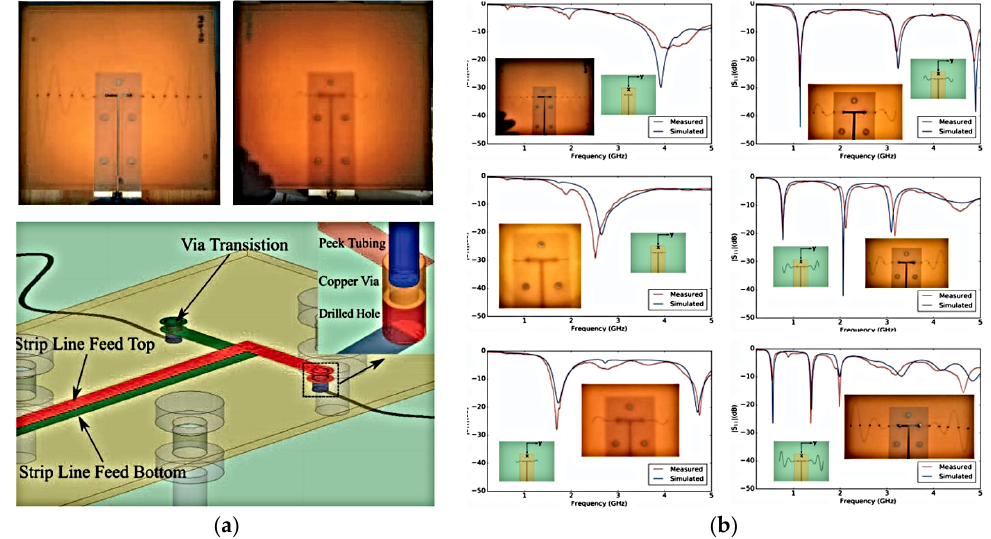
Figure 7. ( a ) Schematic and ( b ) measured/simulated results of the mechanically reconfigurable antenna (redrawn from [59]).